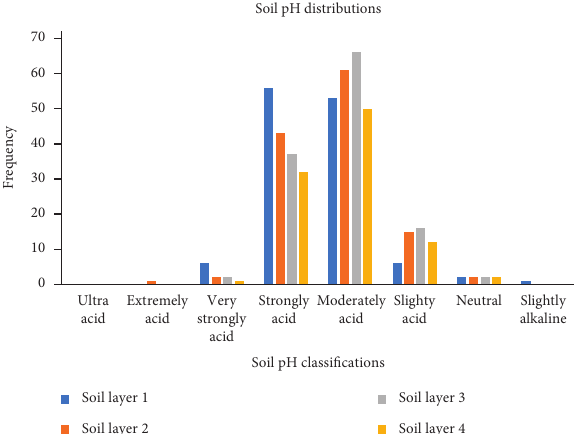
Figure 5: The distributions of soil pH in Bompon watershed. The dominant classes are moderately acid, followed by strongly acid. This condition is the ideal pH level of volcanic soil, especially in areas under high rainfall intensity.